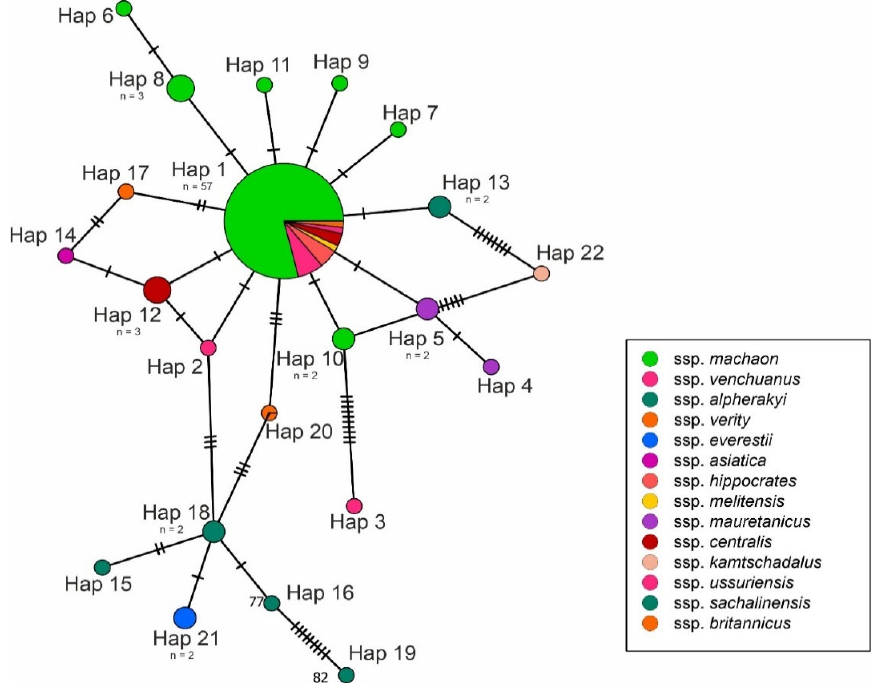
Figure 2. Median ‐ joining haplotype network for 16S rDNA sequences. Different colours are related to subspecies, recognized according to Sturm [3]. The number of individuals with the same haplotype is provided below the haplotype name. Hatch marks along edges represent the number of mutations between nodes. (Hap 17 for 16S rDNA and Hap 25 for cytochrome b), differing from the most common haplotypes only by one and two mutations. The phylogenetic analysis also indicated the lack of sequences distinctiveness of the British specimens of P. machaon .